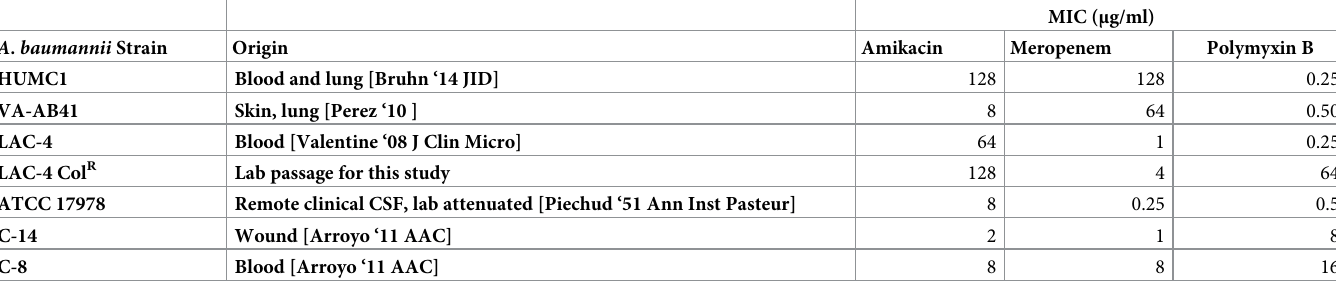
Table 1. Summary of strains used in this